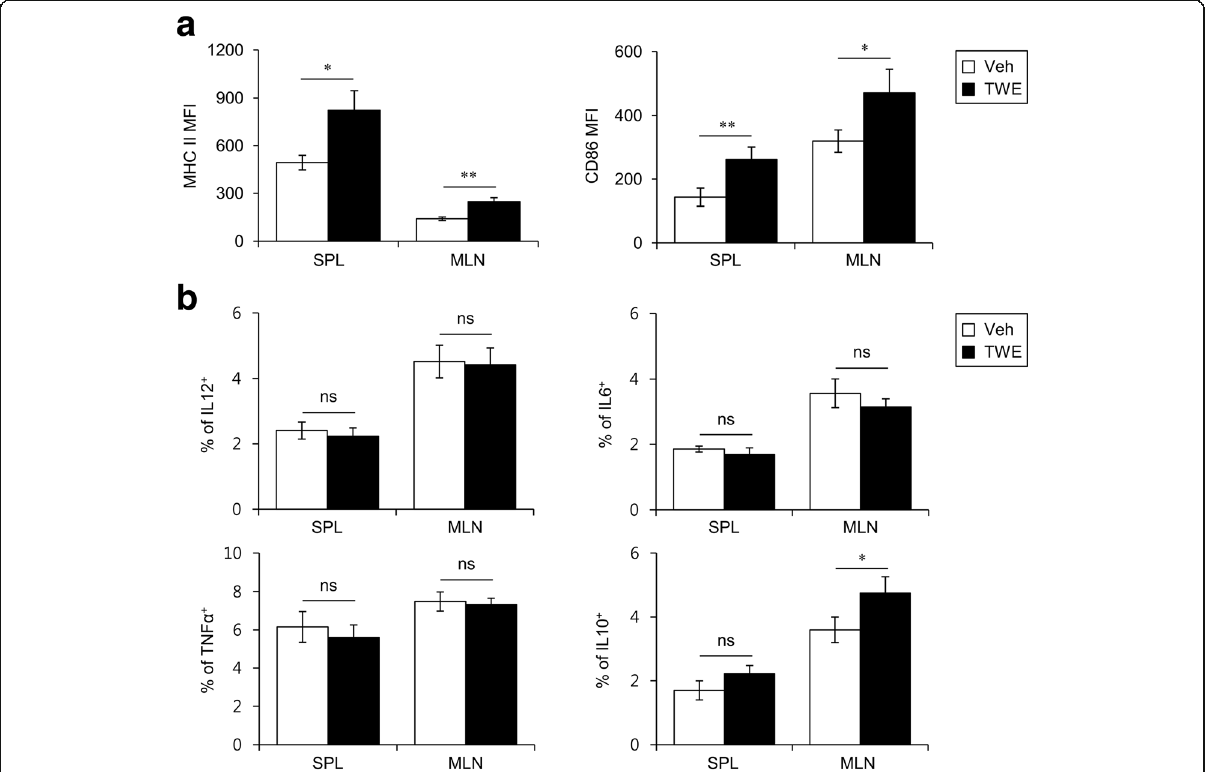
Fig. 1 TWE induces an increase in maturation and production of anti-inflammatory cytokine but does not alter pro-inflammatory cytokine produc- tion by DCs. a Either TWE or vehicle was supplemented in the drinking water of B6 mice for 5 days (approximately 2 mg TWE/day). Subsequently, the surface expressions of MHC II and CD86 molecules on the DCs from the spleen and MLN were assessed by flow cytometry. The graphs repre- sent the mean fluorescence intensities (MFI). The mean values ± SD ( n = 5, * P < 0.05, ** P < 0.01) are shown. b Either TWE or vehicle was supple- mented in the drinking water of B6 mice. After 5 days of TWE ingestion, the frequencies of IL12p40, IL6, TNF α , or IL10-producing DCs of the spleen and MLN were assessed by flow cytometry. The mean values ± SD (n = 5, * P < 0.05) are